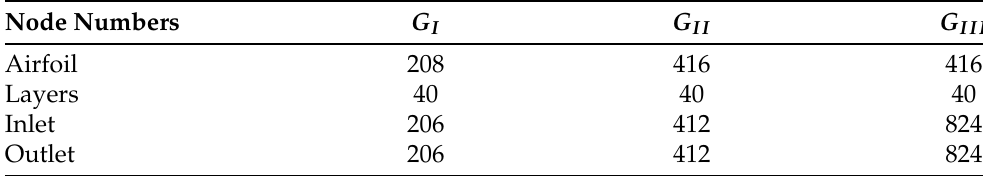
Table 6. Details of the computational